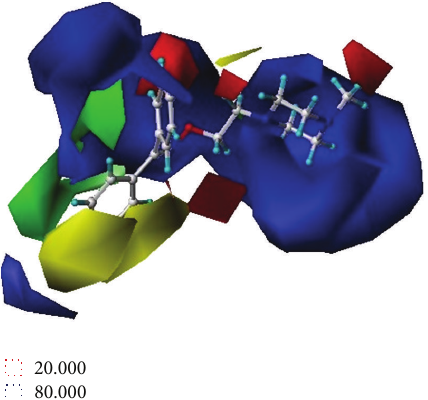
Figure 2: CoMFA contour map for Oryza sativa .